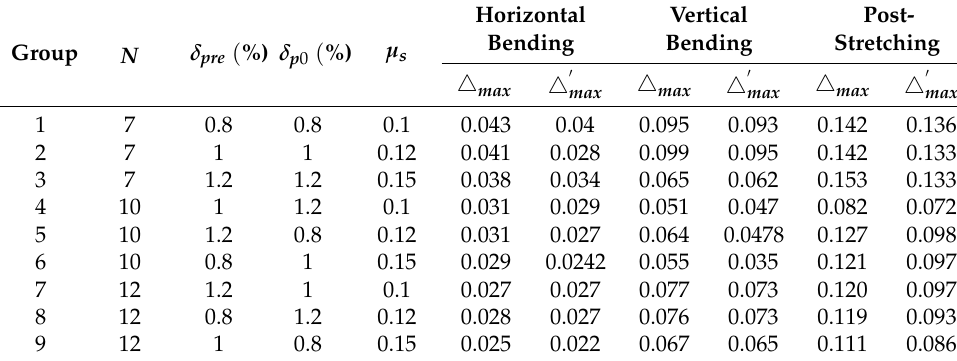
Table 2. Orthogonal table and simulation experiment profile thinning results.